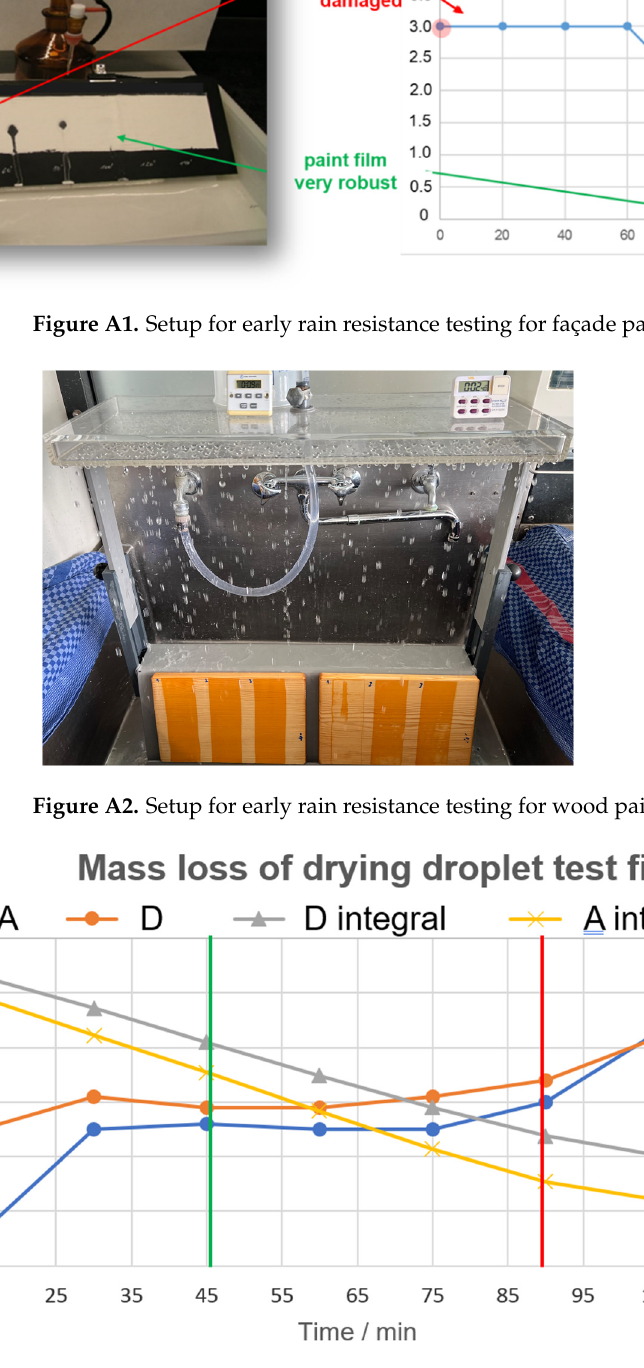
Figure A3. Gravimetric drying kinetics study recorded from films drawn on Leneta foil with a 400 µm doctor blade. The amount of paint applied for binder A was 11.85 g and 11.13 g for binder D. A denotes the paint with reference binder A; D denotes the paint with the new binder containing a tertiary polyamine. The green vertical bar is the latest point in the drying time when the paint behaves as a liquid (from touching with a glove); the red vertical bar is the touch dry point; whereas, in between, the irreversible marks remain on the touched paint surface.